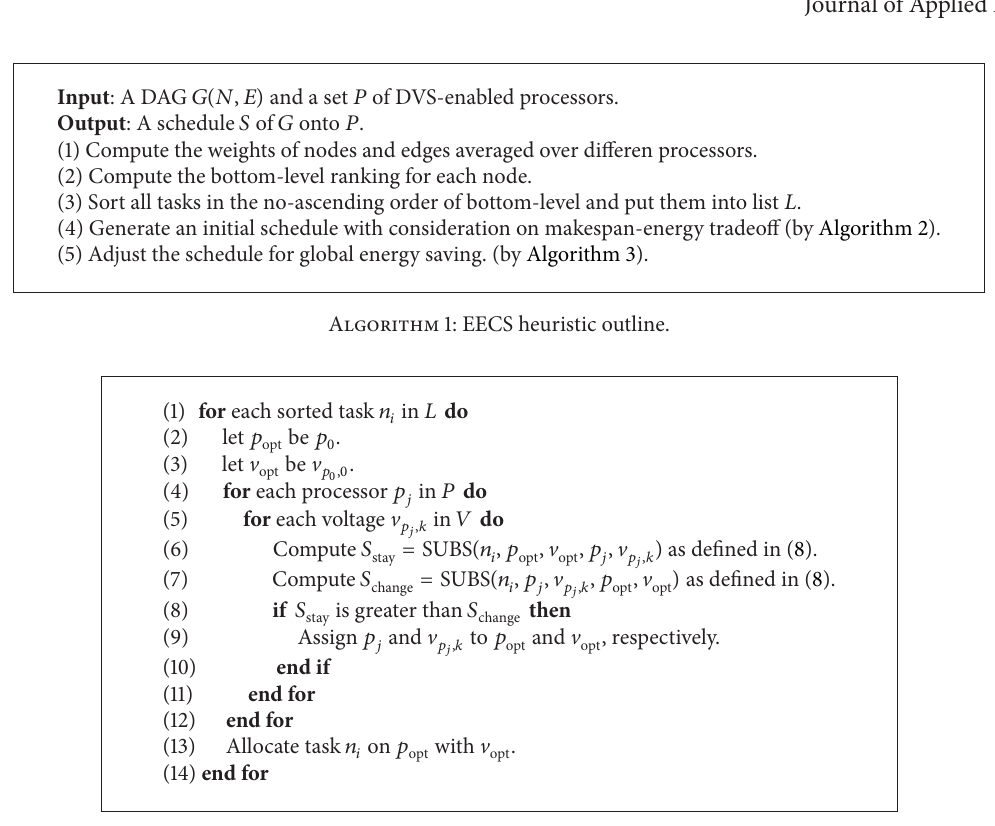
Algorithm 2: Pairwise comparison and selection.